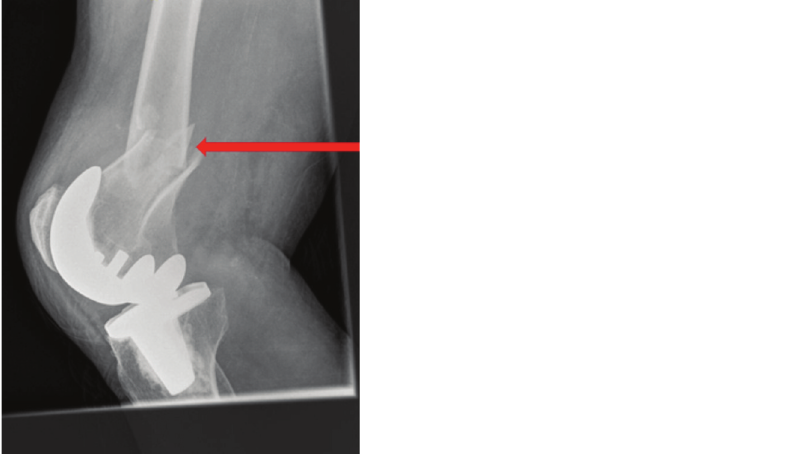
Su type two fracture with well-fixed implant. The fracture is proximal to the femoral component with adequate bone stock Fig. 1: distally (arrow).